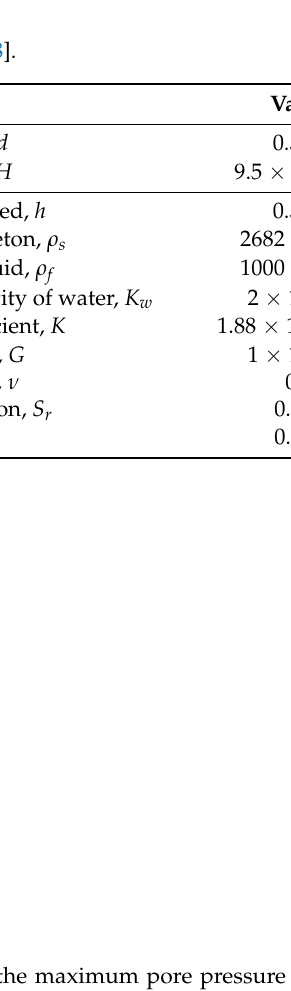
Figure 7. The normalized first-order pore pressure f 2 ( k ), varying with wave number k.